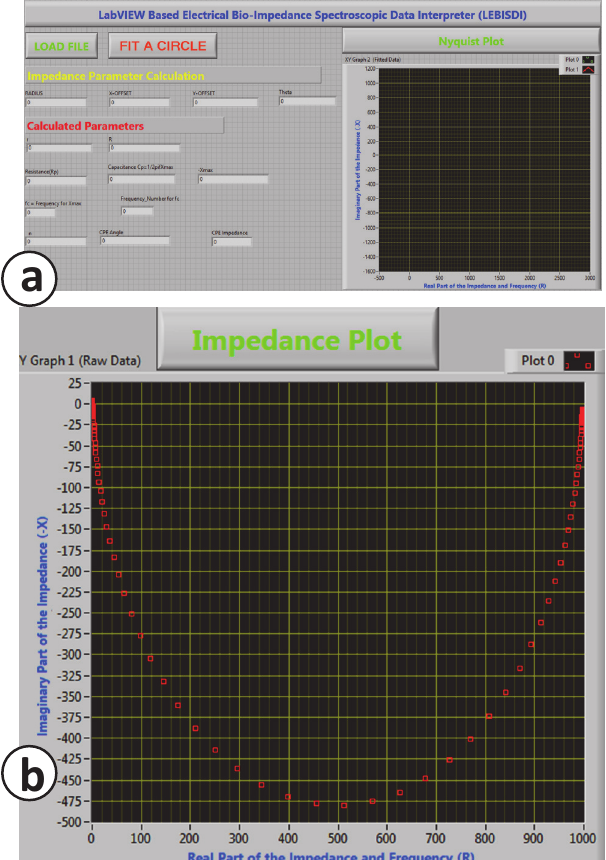
Fig.9: The LabVIEW-based GUI of the LEBISDI and impedance data loaded in LEBISDI. (a) GUI of LEBISDI and (b) the Nyquist plot obtained in LEBISDI after loading real and imaginary impedance data.